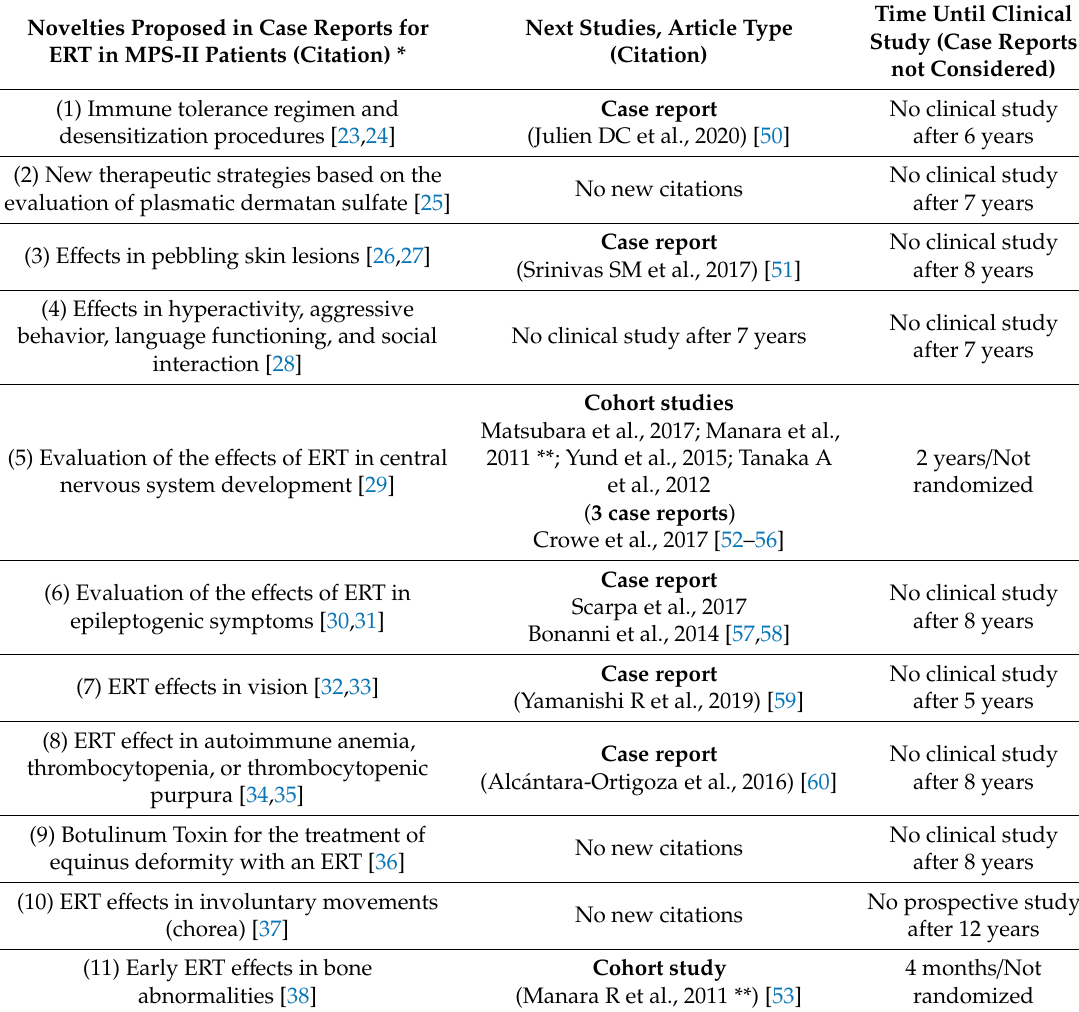
Table 2. Clinical studies evaluating novelties proposed by prior case reports. Novelties Proposed in Case Reports